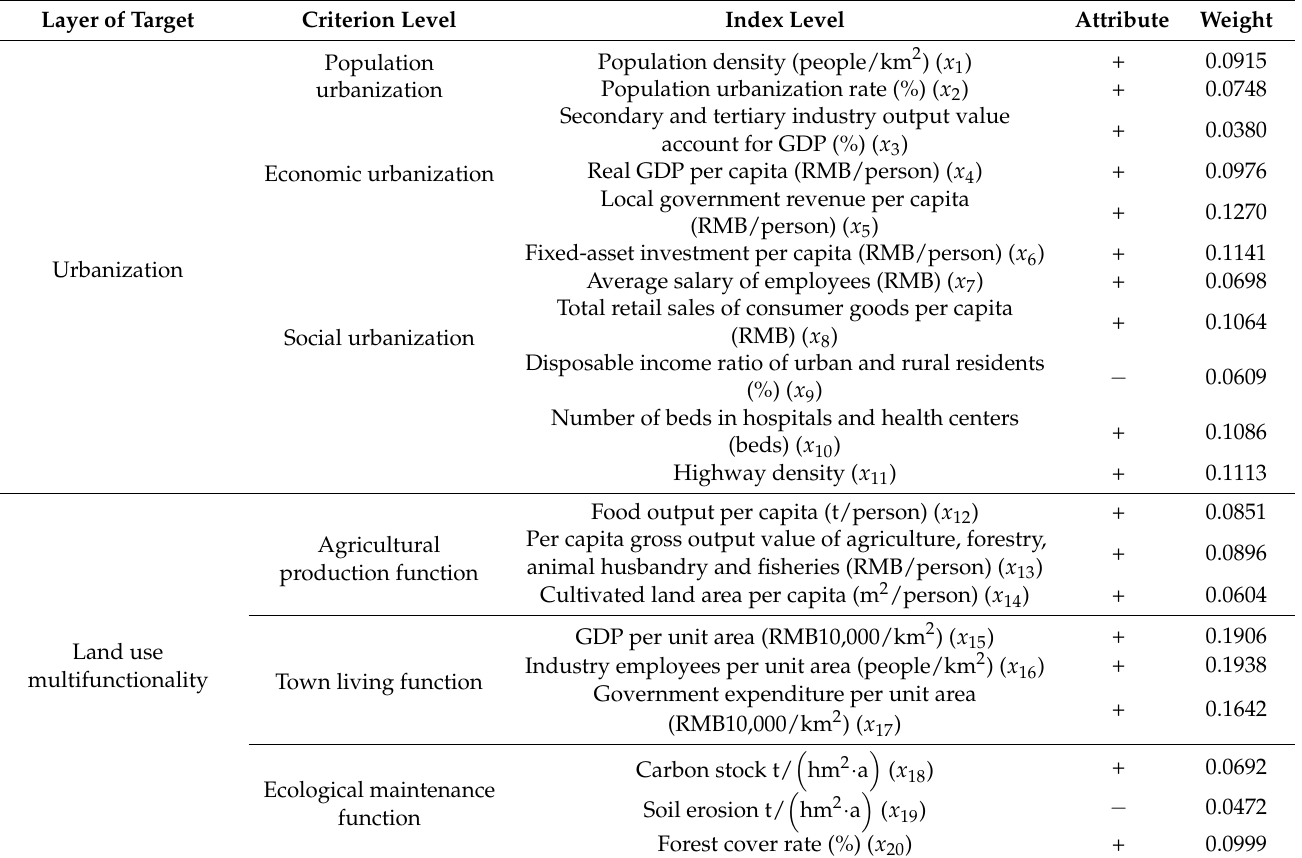
Table 2. Index system of urbanization and